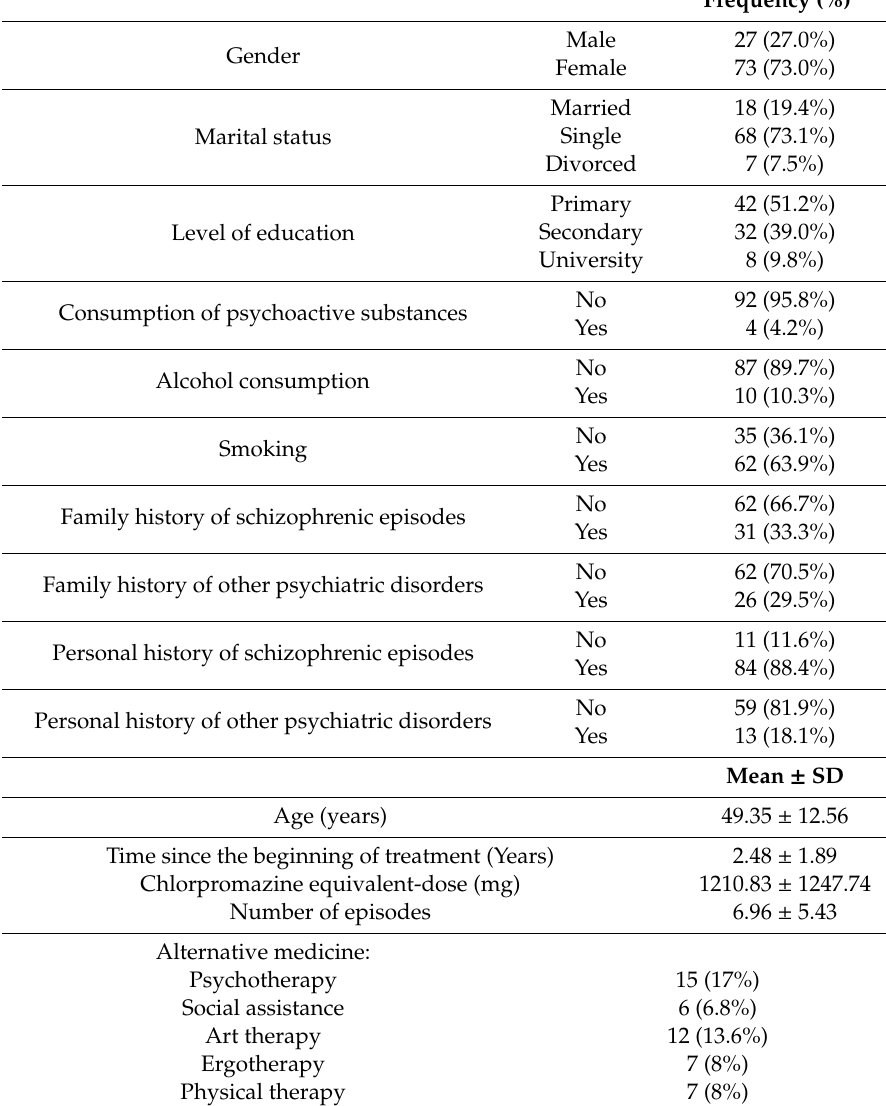
Table 1. Demographic and clinical data of patients.